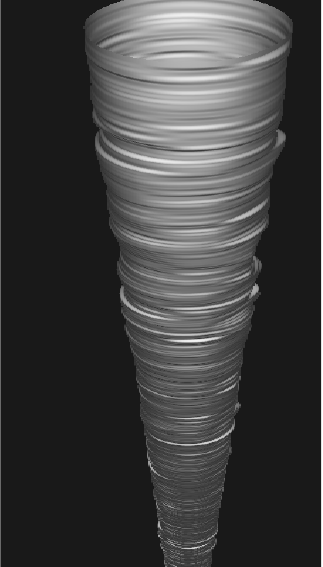
Figure 9. Obtaining a mine model based on the Bresenham method.